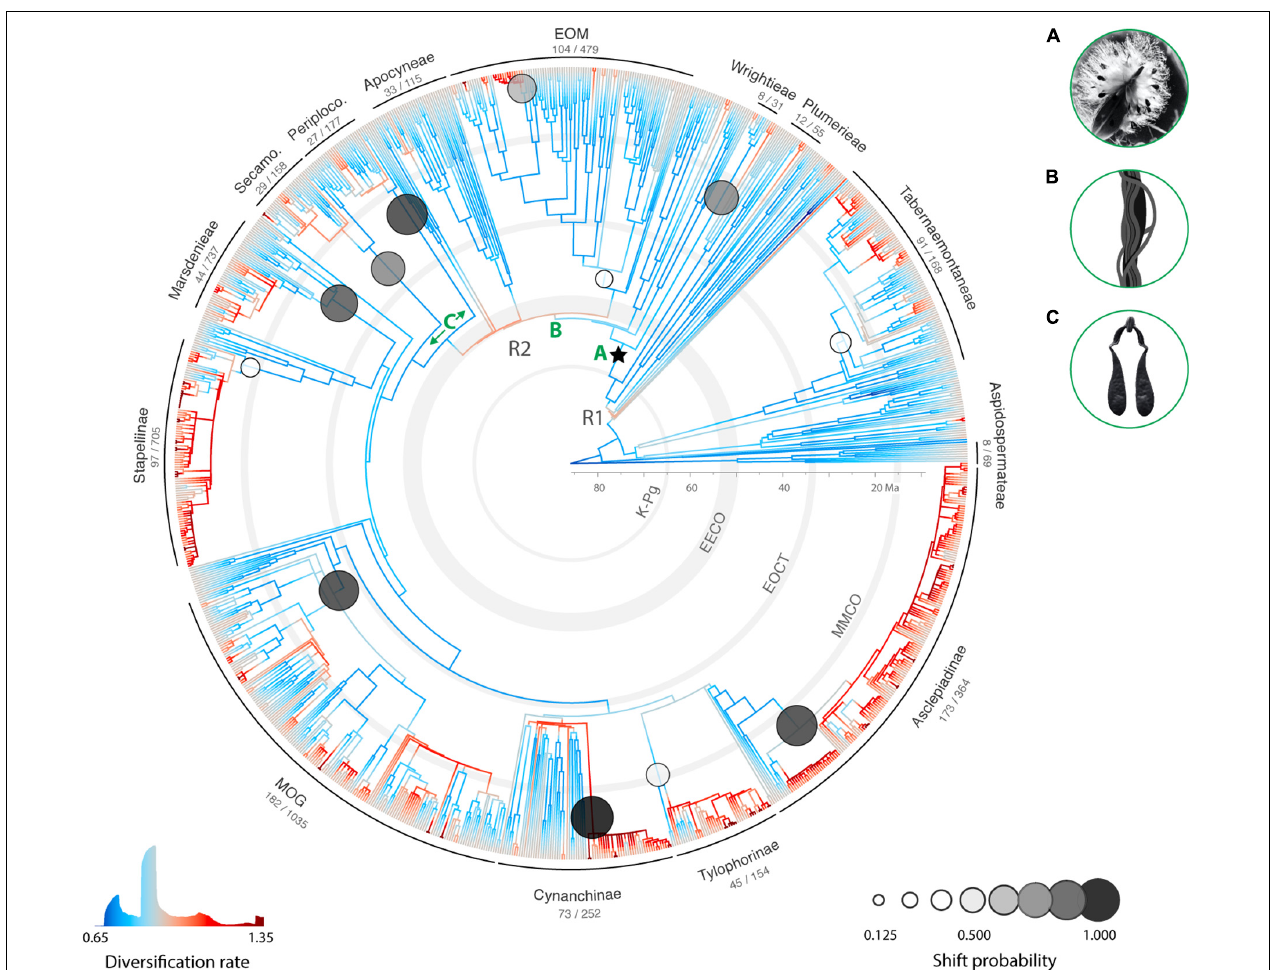
FIGURE 4 | Species diversification in Apocynaceae. Colors on tree branches are averaged net diversification rate estimates inferred by the 52 models varying in the number of rate regimes (“hidden states”; 1–26) with extinction fraction (ratio of extinction to speciation) kept at 0.0 (26 models) or 0.9 (26 models) using MiSSE (rates > 1.35 species per million years are not shown in the color scale). Circles in grayscale superimposed on the tree indicate the nodes for which a shift in diversification rates has been inferred by BAMM and are scaled in gray and size to marginal likelihoods (shift probability; Table 1 ). Selected clade names and sampling fractions (spp. sampled/spp. known; for details see Figure 3 and Supplementary Table 1 ) are indicated. The ancient radiations (internodes with warmer colors) of rauvolfioids (close to R1) and apocynoids (close to R2) are indicated. The star indicates the APSA clade. Secamo., Secamonoideae; Periploco., Periplocoideae. EOM, clade comprising Echiteae, Odontadenieae, and Mesechiteae; MOG, clade comprising Metastelmatinae, Oxypetalinae, and Gonolobinae (plus other five smaller Neotropical subtribes). K-Pg, Cretaceous-Paleogene boundary; EECO, early Eocene climatic optimum; EOCT, Eocene-Oligocene climate transition; MMCO, middle Miocene climatic optimum. Insets top right are potential drivers of diversification: A, dry fruits with comose seeds; B, climbing habit (twining growth form) and; C. pollinarium with a pair of pollinia, indicating the two pollinia-bearing lineages as discussed in the